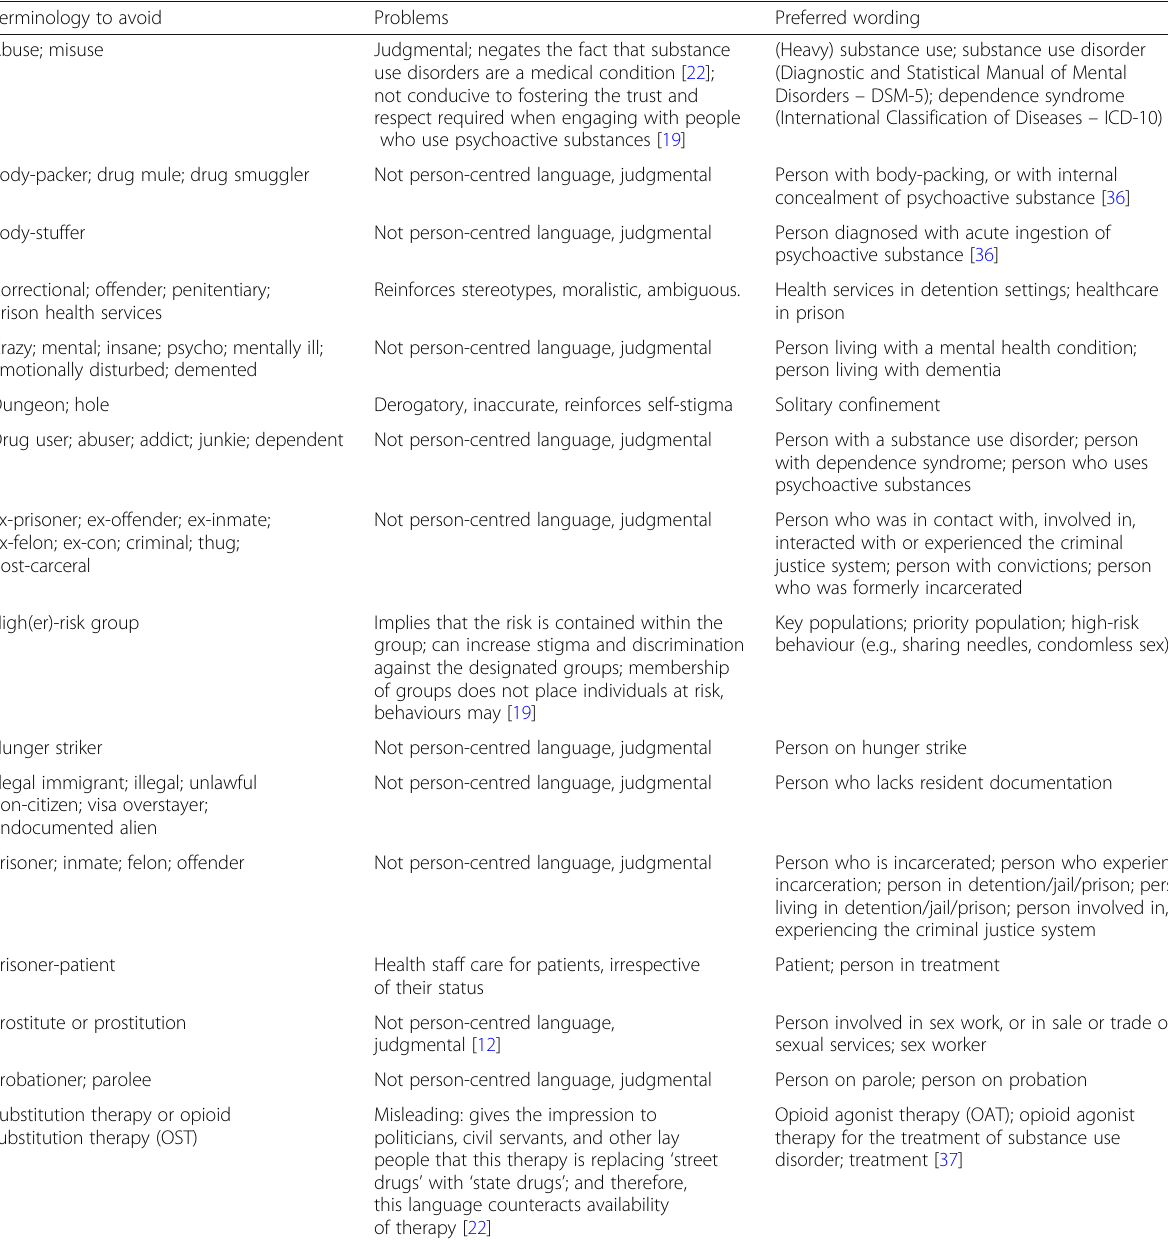
Table 1 Examples of terminology to avoid (in alphabetical order), problems related to its use, and preferred wording to describe people who are